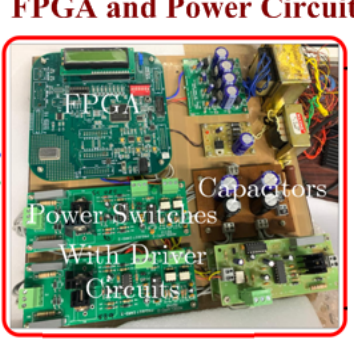
Figure 11. Experimental setup of proposed converter.